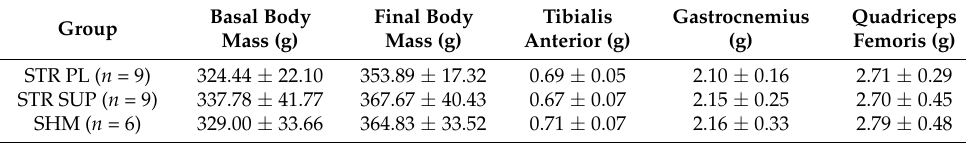
Table 5. Mean muscle weight: body weights ratio in stressed rats. SOL Weight: Body Weight Group Ratio ( × 10 − 3 )